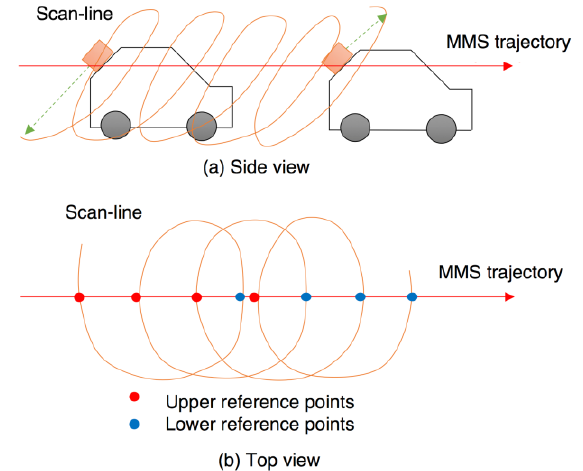
Figure 7. An MMS trajectory, a scan-line, and reference points